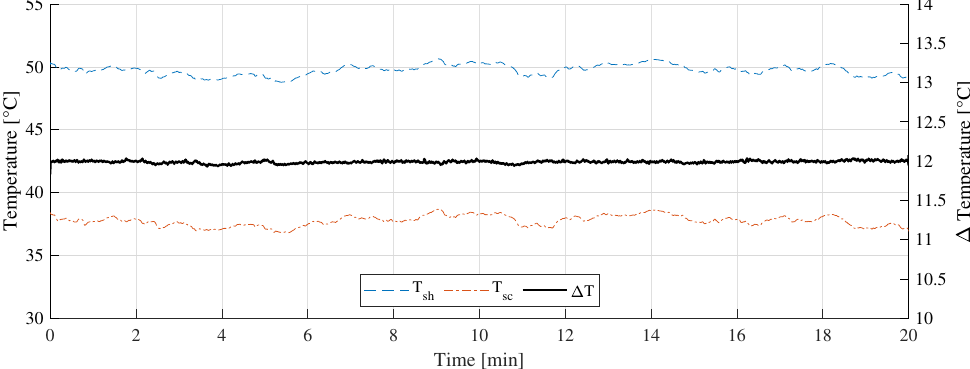
Figure 16. Temperature measurement during the B measurement. Figure 17 shows the “C” measurement taken on 18 February 2022 at 11:30 a.m. with cloudy weather conditions. Nimbostratus clouds were present but without rain. Figure 18 shows the measurement difference between the CTD prototype and the pyranometer in “C” measurement. The absolute error measured was 64 ± 53 W/m 2 . Figure 19 shows the temperatures of the hot sensor ( T sh ), cold sensor ( T sc ), and the temperature difference ( ∆ T